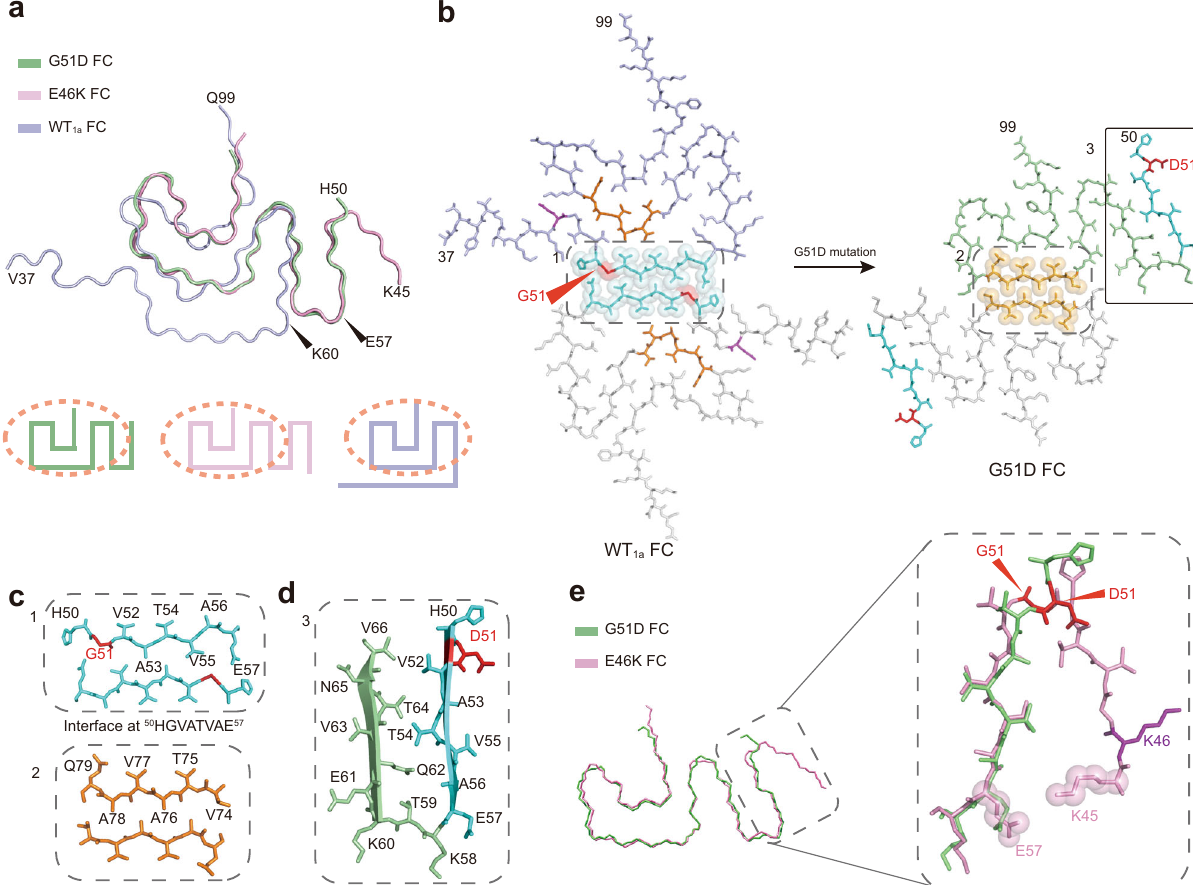
Fig. 3 Structure comparison of G51D, WT 1a, and E46K fi brils. a Overlay of the structures of every single α -syn subunit from the G51D, E46K, and WT 1a fi brils. G51D fi bril is in green; WT fi bril is in slate; E46K fi bril is in pink. The region with a similar structure shared by three different FC is circled on 1a topology diagrams. b Rearrangement of α -syn fi bril structure triggered by G51D mutation. Residues involved in the proto fi lament interfaces are presented in spheres. The proto fi lament interface of WT 1a fi bril is colored in cyan; the interface of the G51D fi bril is colored in orange. D51 and G51 are highlighted in red. E46 and K46 are in purple. c Zoom-in views of the WT 1a and G51D fi bril interfaces. d The β -hairpin (residues 50 – 66) formed in the G51D fi bril structure is zoomed in with D51 in red. e Overlay of the structures of every single α -syn subunit from the G51D and E46K fi brils. G51D mutation disrupts the β -turn formed of residues 45 – 57 formed in the E46K fi bril. G51 and D51 are highlighted in red. K46 is highlighted in